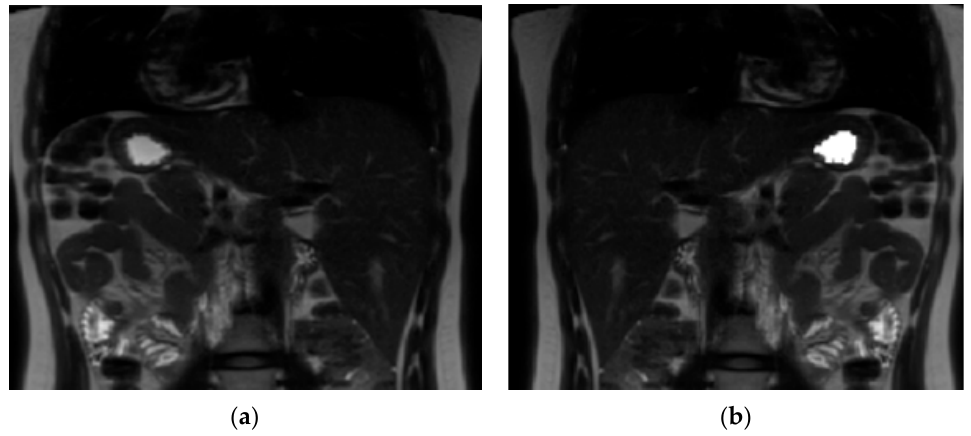
Figure 2. Image analysis using FMRIB’s Software Library (FSL v5.0.11). ( a ) Magnetic resonance image of the stomach before drinking milk. ( b ) Magnetic resonance image of the stomach with the mask of the stomach acid content at baseline.